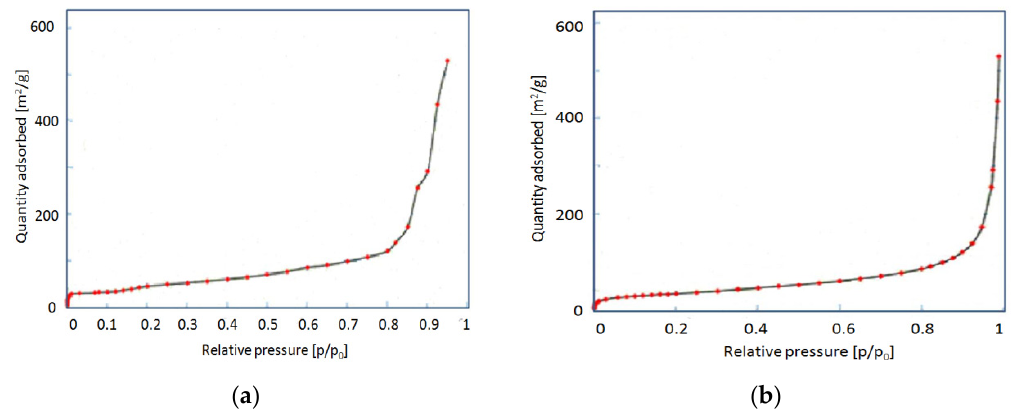
Figure 2. Isotherms of N 2 adsorption: ( a ) Nonpurified nanotubes; ( b ) purified nanotubes.